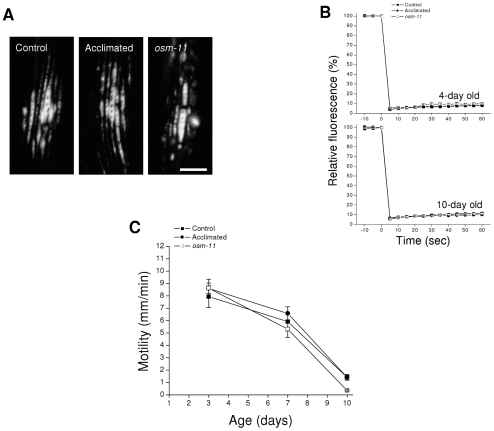
Effect of elevated glycerol levels on the properties of age-induced Q35::YFP aggregates.
A: Fluorescence micrographs of aggregate morphology in body wall muscle cells of control worms, worms acclimated to 200 mM NaCl and osm-11 mutant animals. Images were taken from 7-day old adult worms. Scale bar is 10 µm. B: Time course of bleaching and fluorescence recovery in aggregates of young (4-day old) and old (10-day old) adult control, acclimated and osm-11 worms (n = 3). C: Aggregate toxicity in control, acclimated and osm-11 worms. Toxicity is measured as reductions in motility, which is mediated by body wall muscle cells. (n = 5–12).